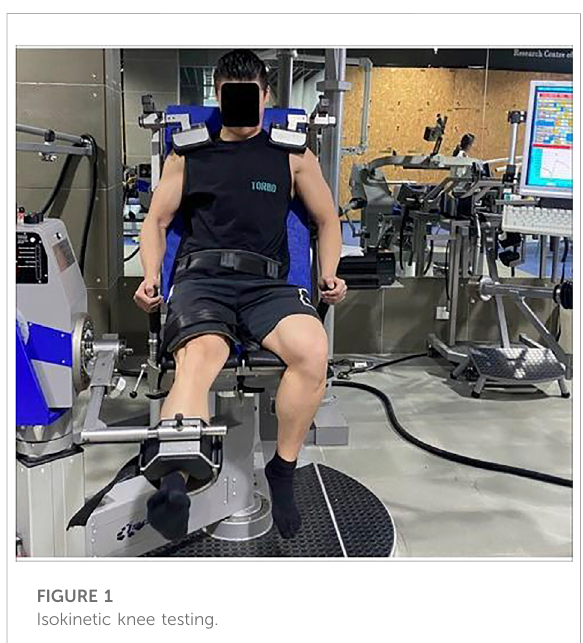
FIGURE 1 Isokinetic knee